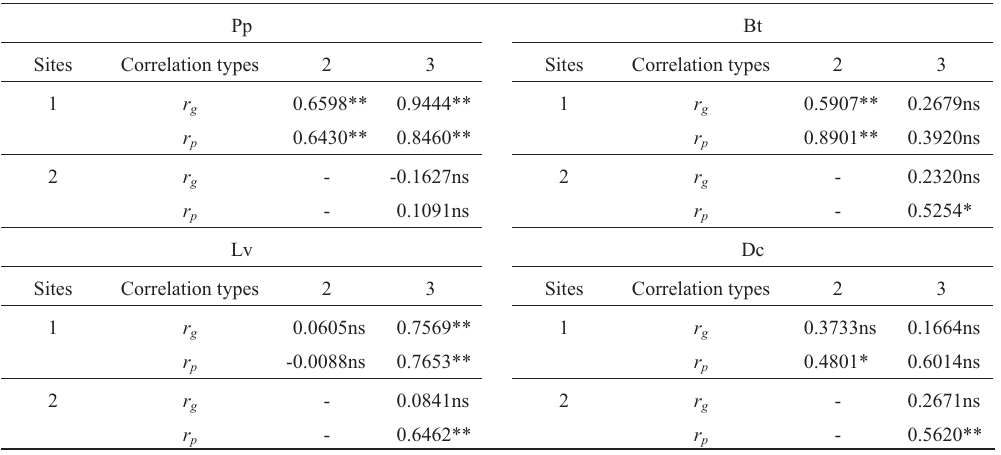
Table 4 - Genotypic ( r g ) and phenotypic ( r p ) correlations among Votuporanga (1), Pindorama (2) and Jaú (3) sites for rubber yield (Pp), bark thickness (Bt), number of latex vessel rings (Lv), average distance between consecutive latex vessel rings (Dc), density of latex vessels per ring (Dd), diameter